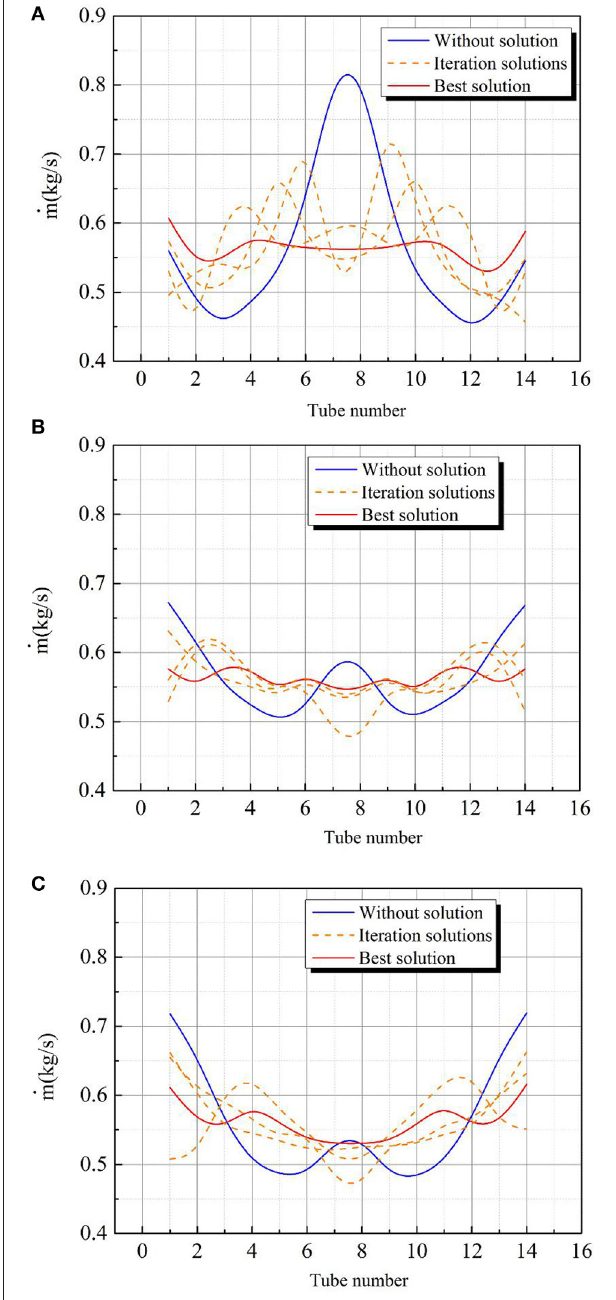
FIGURE 8 | The mass flow rate for three base cases (A) Mass flow rate in tubes for Case 1 (B) Mass flow rate in tubes for Case 2 (C) Mass flow rate in tubes for Case